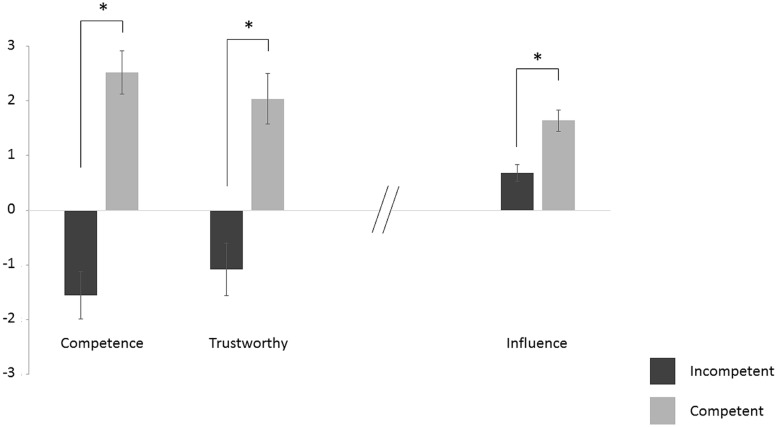
Post-test results. Participants’ explicit evaluation of social agents at the end of the experiment with SE bars. The asterisks indicate significant statistical difference.